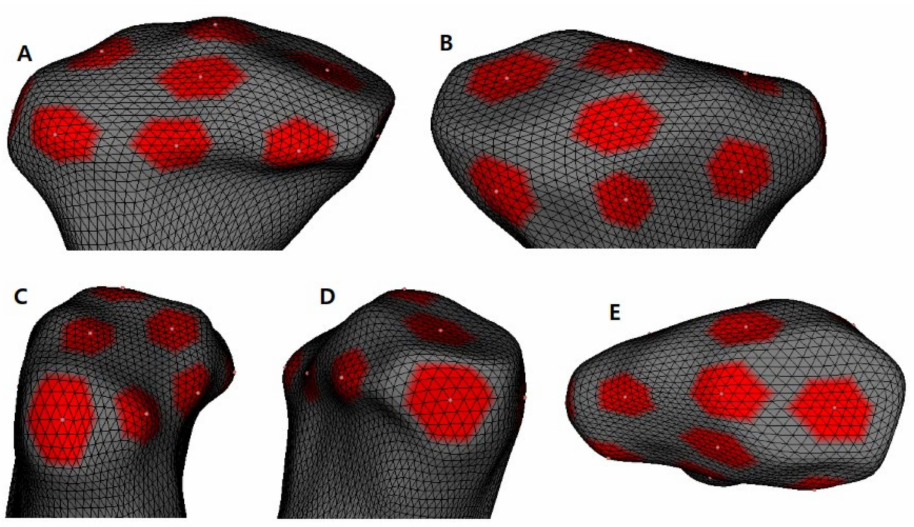
Figure 4. Close-up view of the areas used for the mesh statistics; ( A ), anterior view; ( B ), posterior view; ( C ), lateral view; ( D ), medial view; ( E ), superior view.